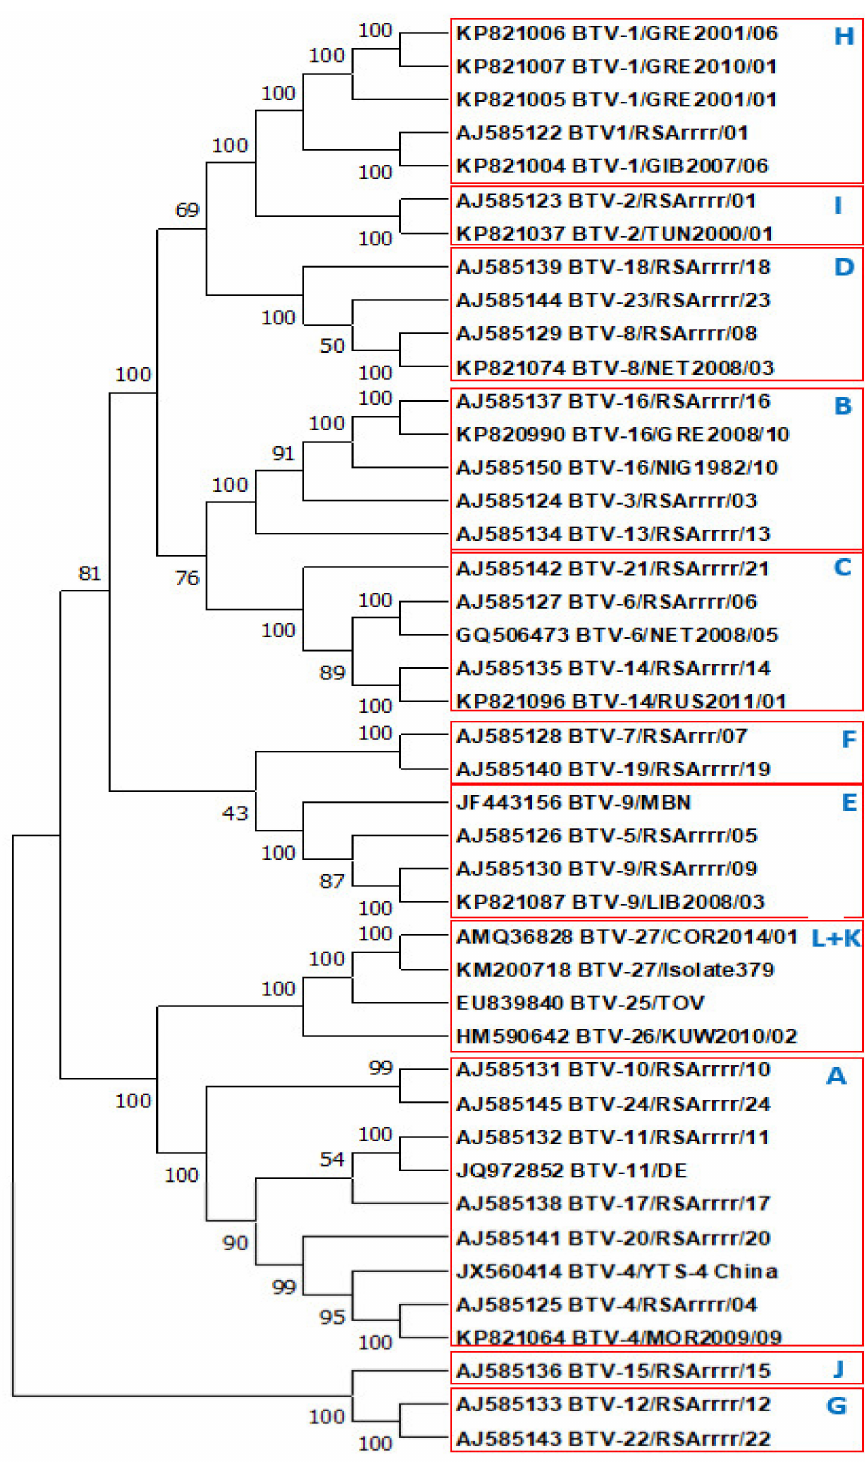
Figure 1. Phylogenetic tree illustrating relationships between VP2 aa sequences of different BTV serotypes. Figure 1: A neighbour-joining phylogenetic tree constructed with aa sequences of VP2(OC1) of BTV-1 to BTV-27 depicting phylogenetic groupings. The tree was generated using the p-distance algorithm (pairwise deletion) implemented in the MEGA X software program. VP2/Seg-2 nucleotypes are indicated as previously reported [41] although with novel serotypes BTV-25, -26 and -27 are included in nucleotype